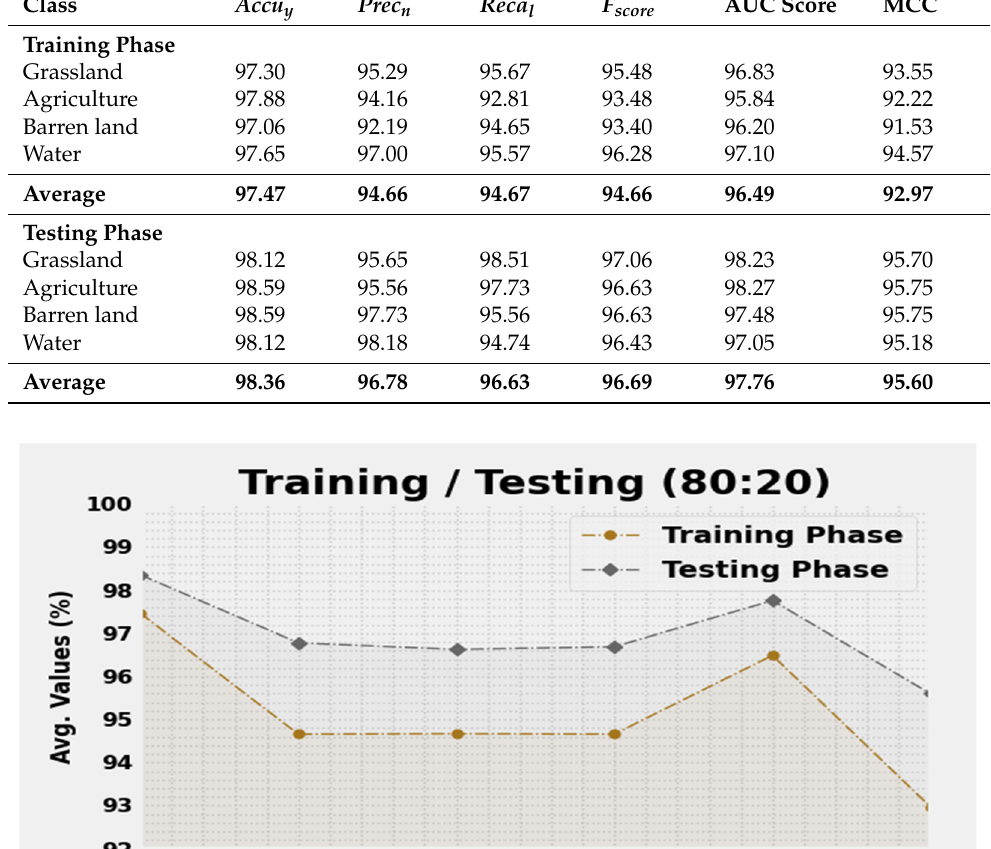
Table 2. Classification outcome of TSADL-LULCCD approach on 80:20 of TR/TS databases. Class 𝑨𝒄𝒄𝒖 𝒚